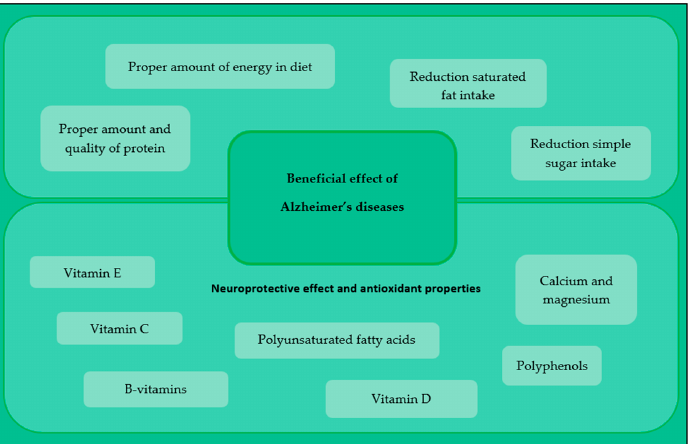
Figure 2. The effect of nutritional factors on Alzheimer’s